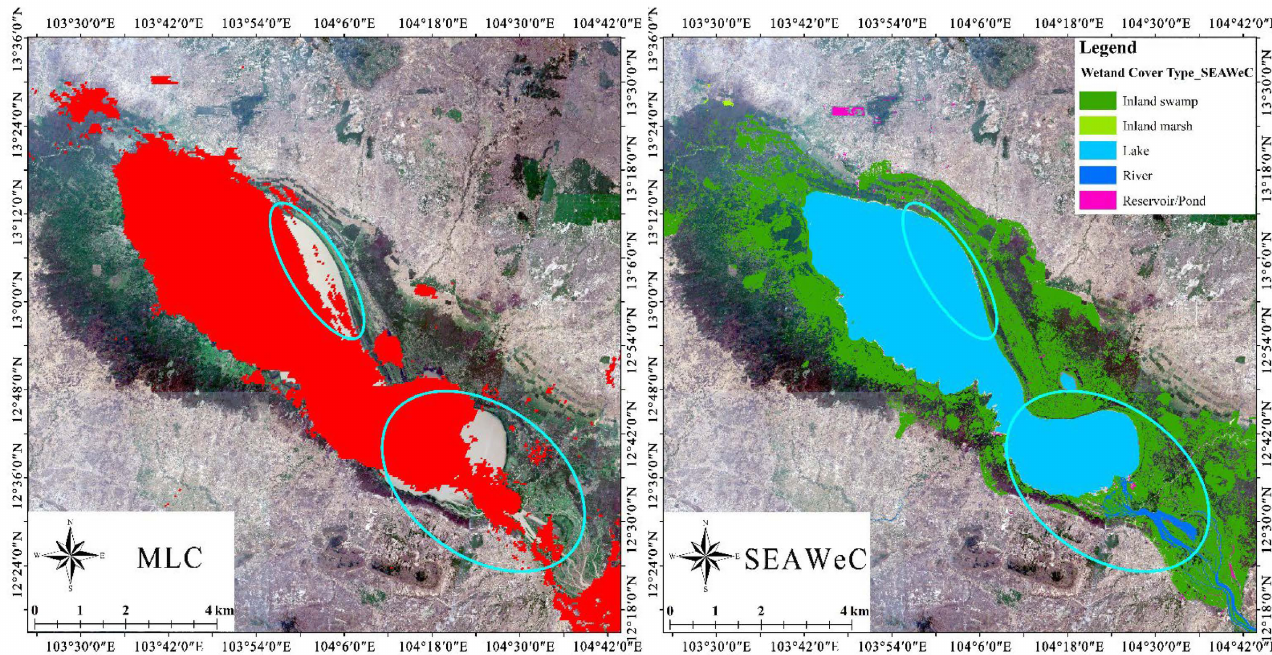
Figure 12. A comparison of the SEAWeC from the GTF product.